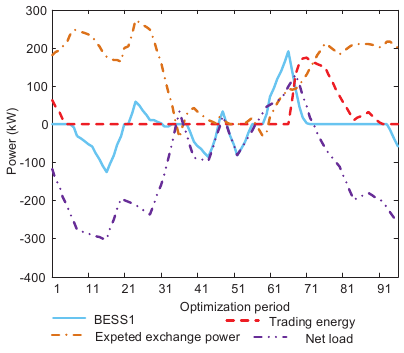
Figure 17. The optimal variables and net load in MG1 on Day 2 of Scenario 1.